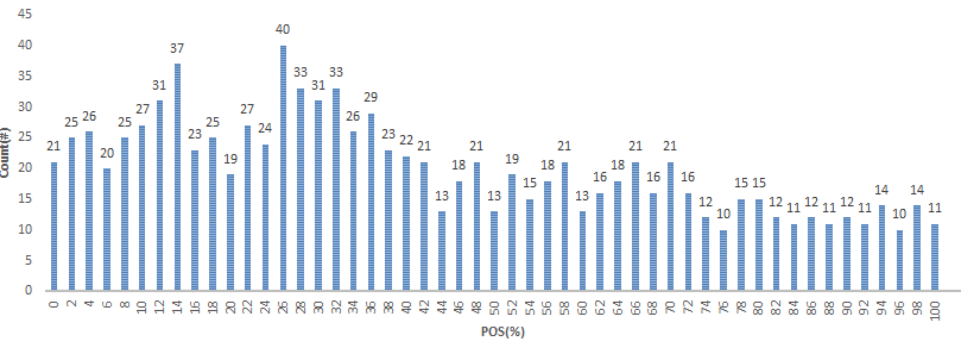
Figure 13. Distribution of solutions obtained by the PUSS model under different scenario probabilities.